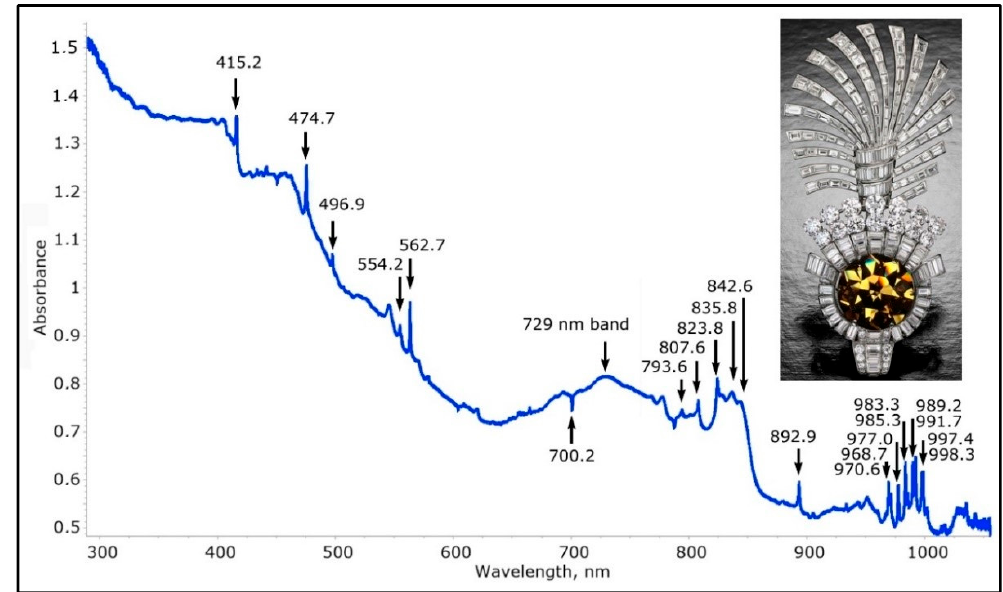
Figure 18. The low temperature UV-Vis-NIR spectrum of the most famous and biggest hydrogen-rich brown yellow diamond that is colored by NDR defects—the Tiger’s Eye diamond, 61.56 cts. The highly complex spectrum is characteristic for these diamonds, and is always the continuation of the very distinct triplet ZPL at 1330.8/1332.0/1341.0 nm (7514/7507/7457 cm − 1 ); this intense ZPL—which is the strongest vibronic absorption feature in the entire NIR, Vis and UV range, is also present in the NIR spectrum of the Tiger’s Eye diamond. The majority of the features of these spectra are likely related to nickel-nitrogen defects, possibly with the incorporation of hydrogen.